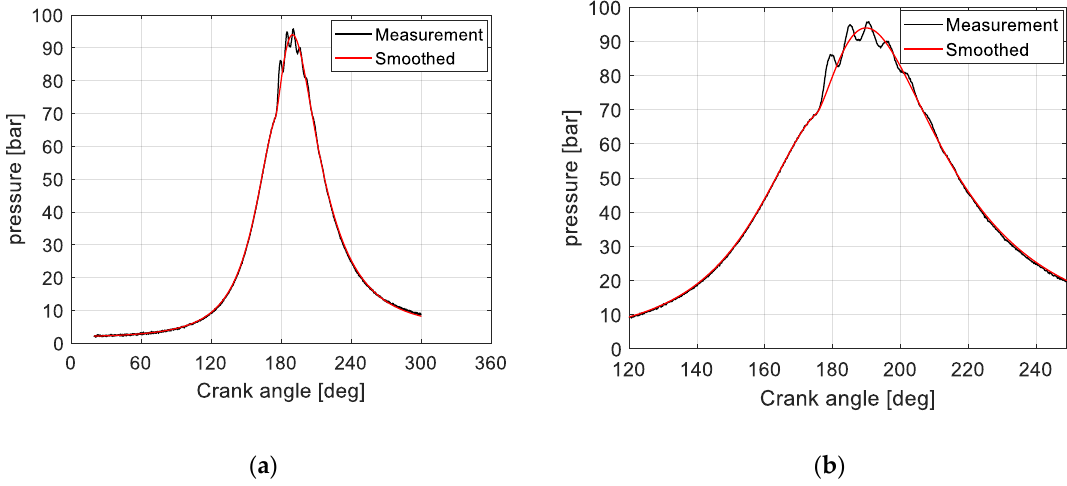
Figure 9. In-cylinder pressure of 4 cylinders: ( a ) The smoothed pressure signals; ( b ) Zoom in of peak pressure region. Table 3. The goodness of fit of the pressure signals.